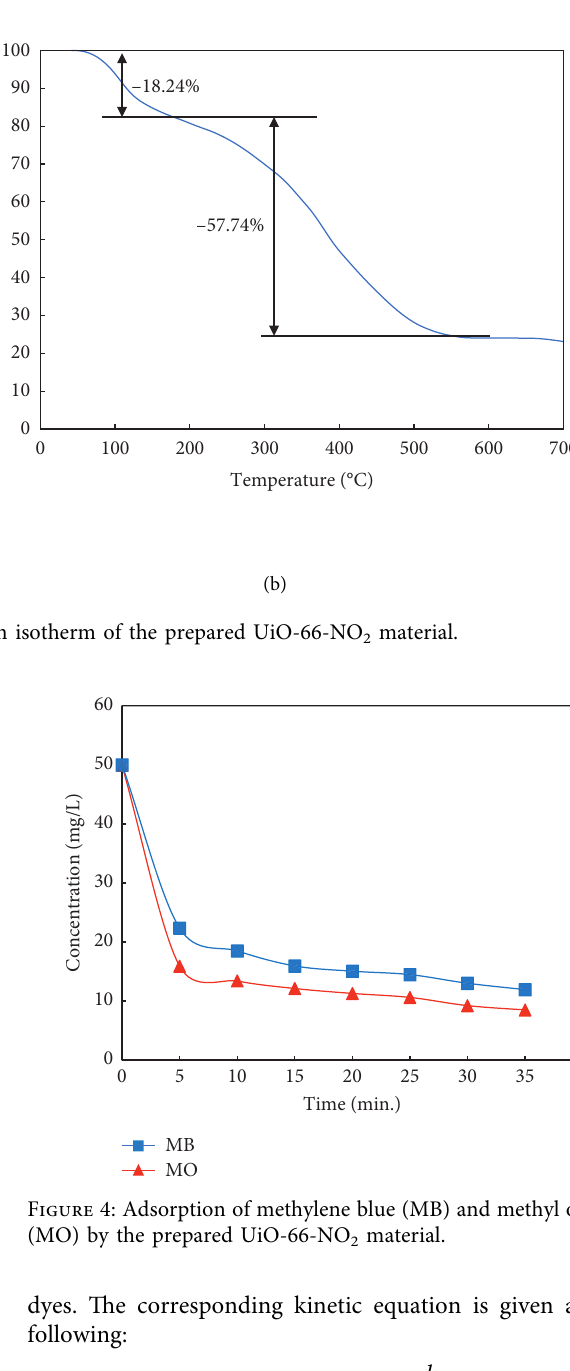
Figure 4: Adsorption of methylene blue (MB) and methyl orange (MO) by the prepared UiO-66-NO 2